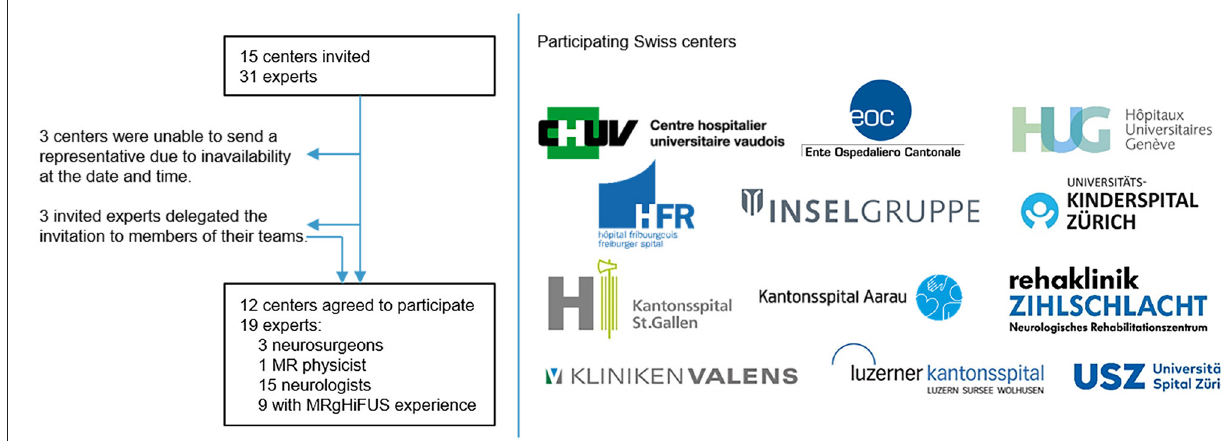
FIGURE 1 | Process of invitation for constitution of the MRgHiFUS workgroup.